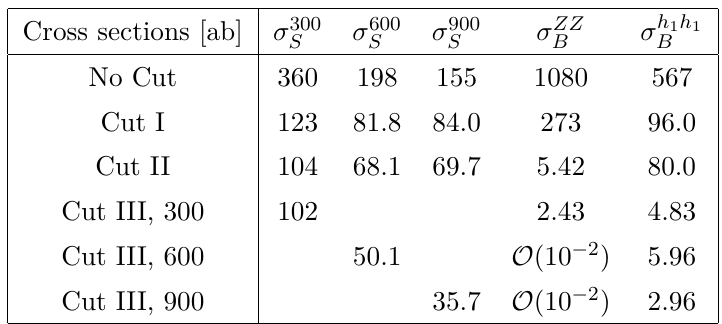
Table 1 . Cut flows at a 10 TeV muon collider for the signals with M h the backgrounds. For the signals, we have assumed s θ = 0 . 1 and Br ( h 2 → h 1 h 1 ) = 25%